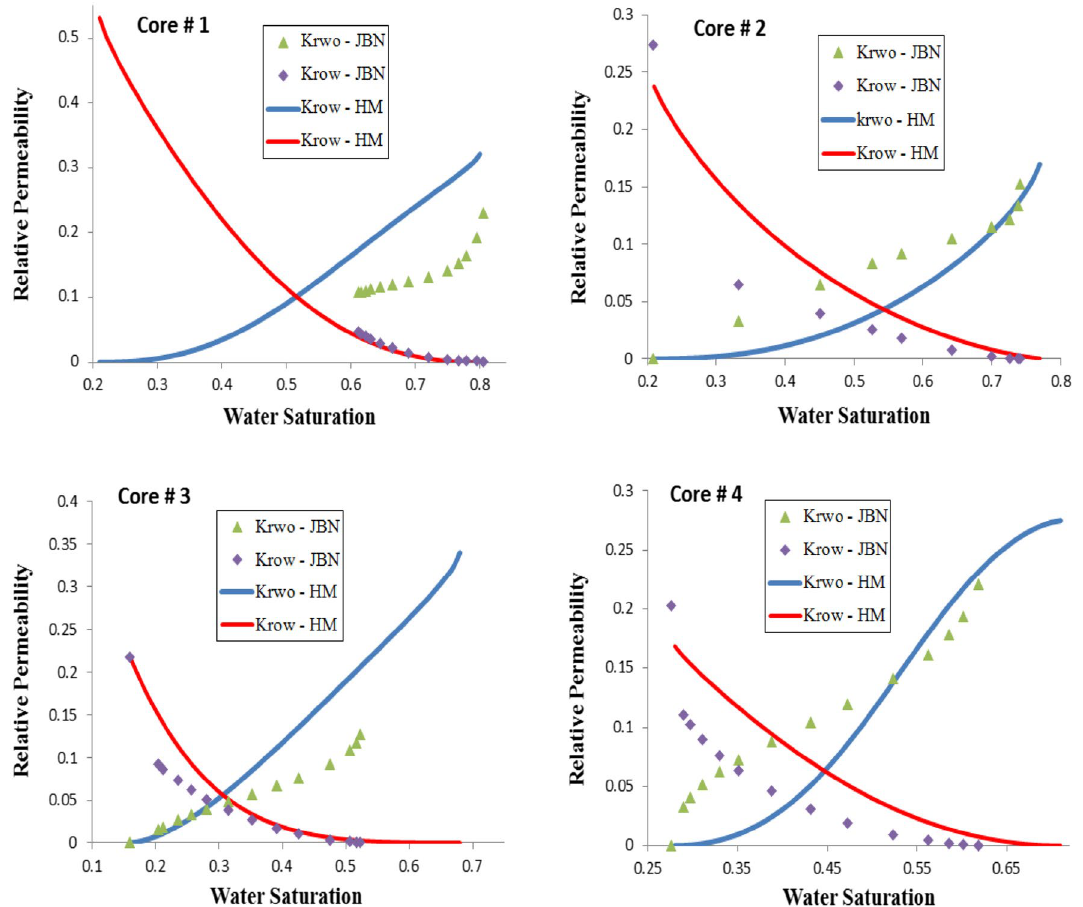
Fig. 3 Oil and water relative permeability calculated by the history-matching technique (HM) and the analytical method (JBN) for various